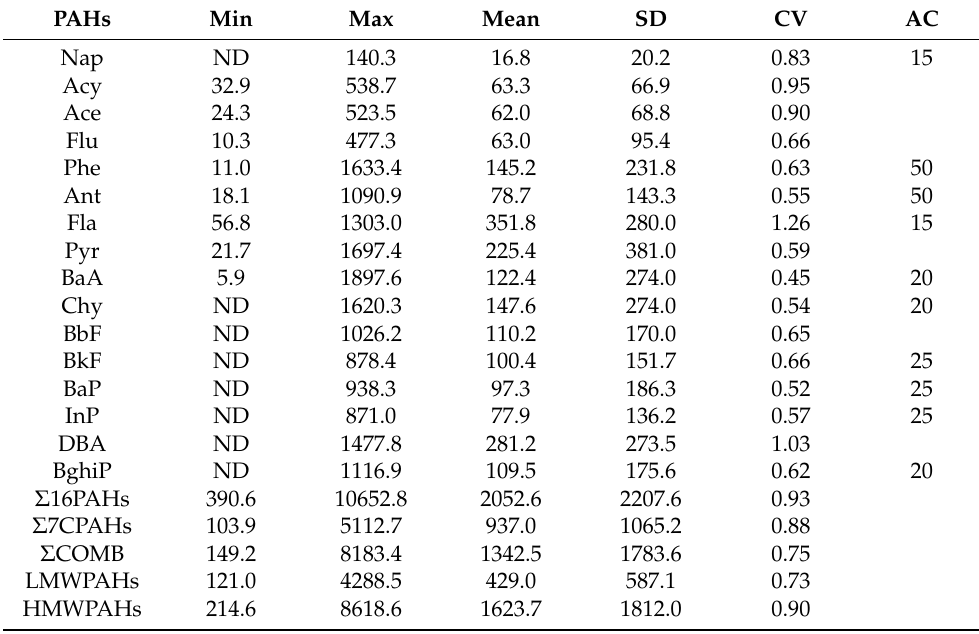
Table 3. Concentration of PAHs in urban soil of Xi’an ( µ